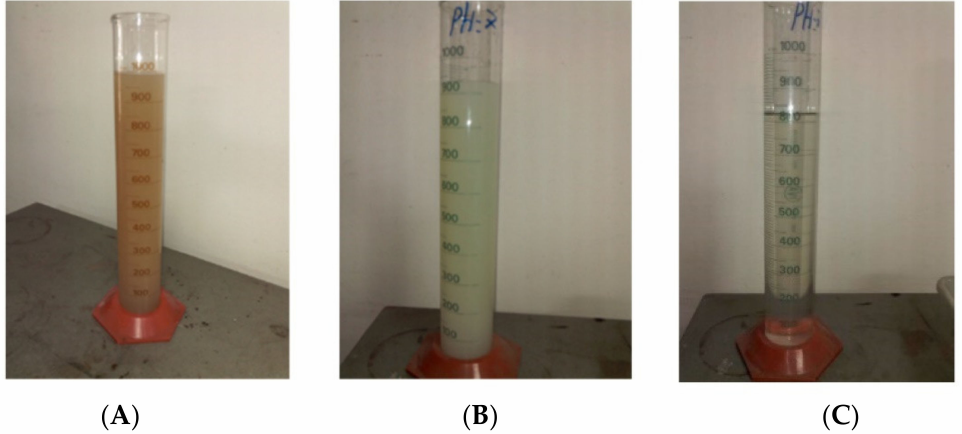
Figure 16. Precipitation using FeCl 3 . ( A – C ) First picture: ( A ) before treatment, ( B ) acid added and ( C ) FeCl 3 added.